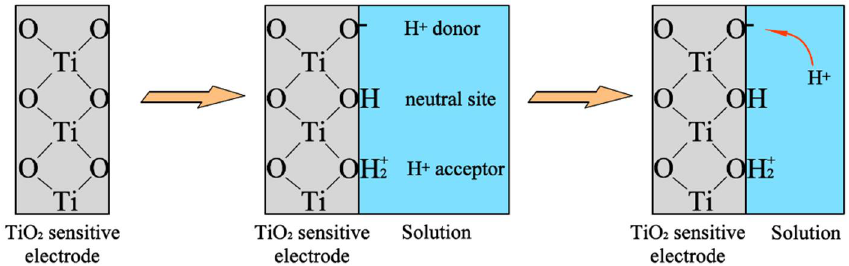
Figure 7. Schematic of the detection principle and procedure of the TiO 2 pH-sensitive electrode.